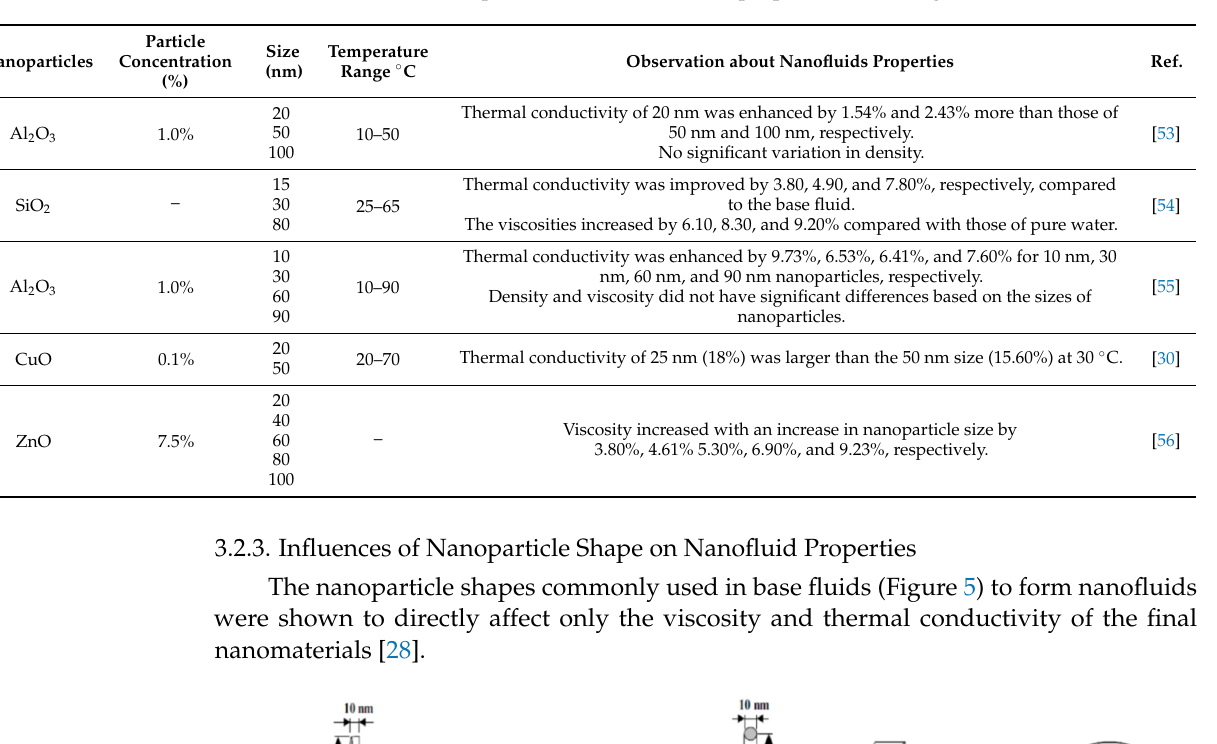
Figure 4. Variations in the thermal conductivities ( a ) and the dynamic viscosities ( b ) of the SiO 2 − water nanofluids as a function of temperature and particle size [54]. Table 4. Influences of nanoparticle size on nanofluid properties according to different studies.